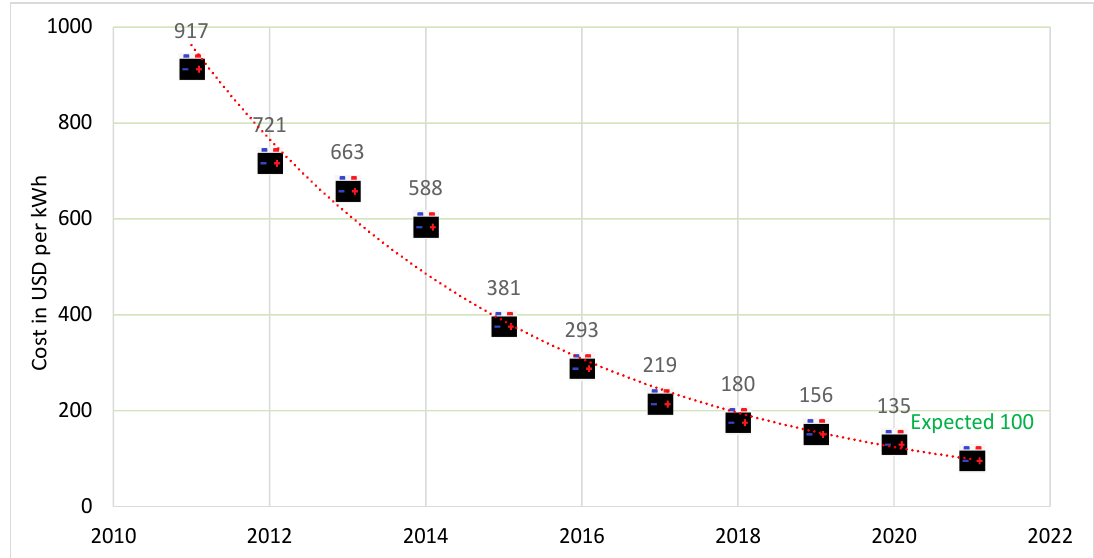
Figure 9. Li-ion battery price in the last decade.